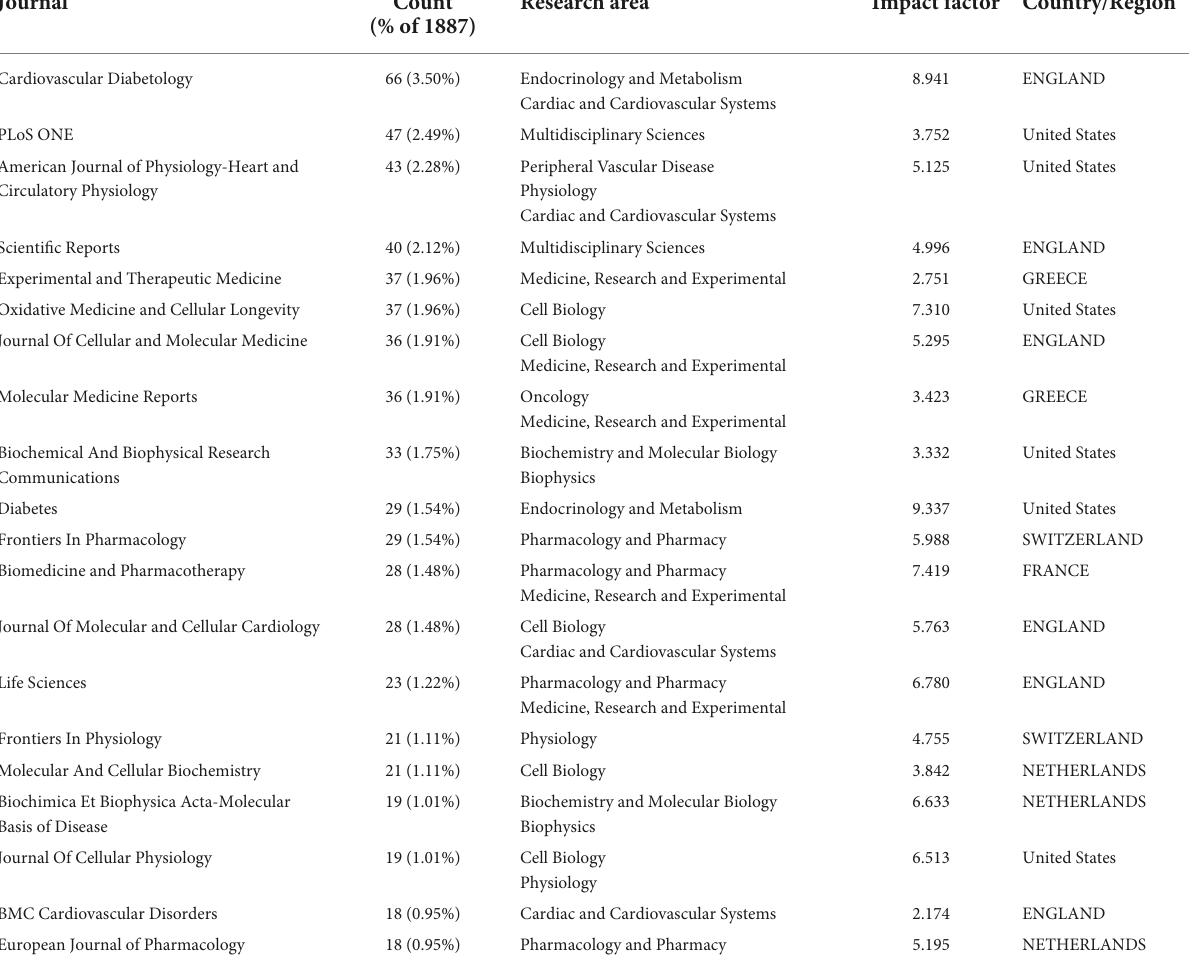
TABLE 3 Top 20 journals contributing to publications in diabetic cardiomyopathy in the past